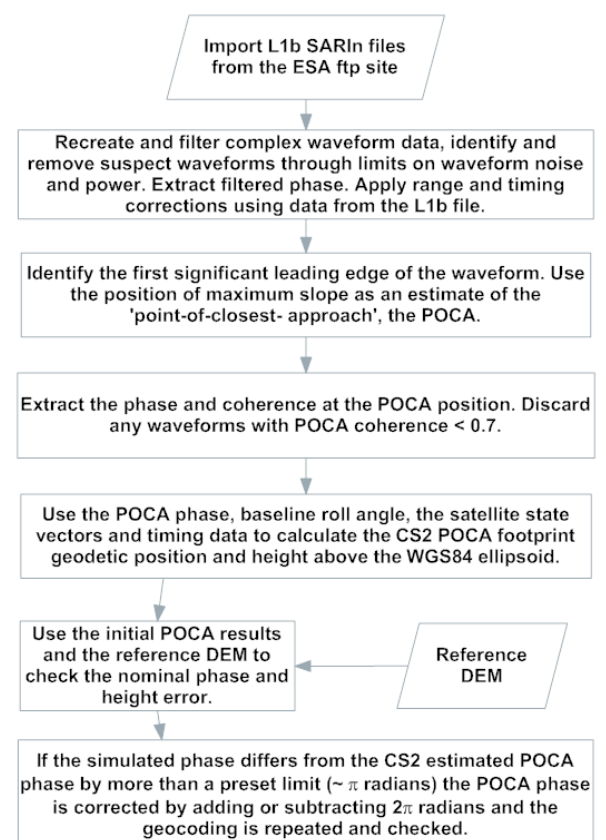
Figure 2. Flow chart showing the methodology developed to derive terrain elevation from the L1b SARIn